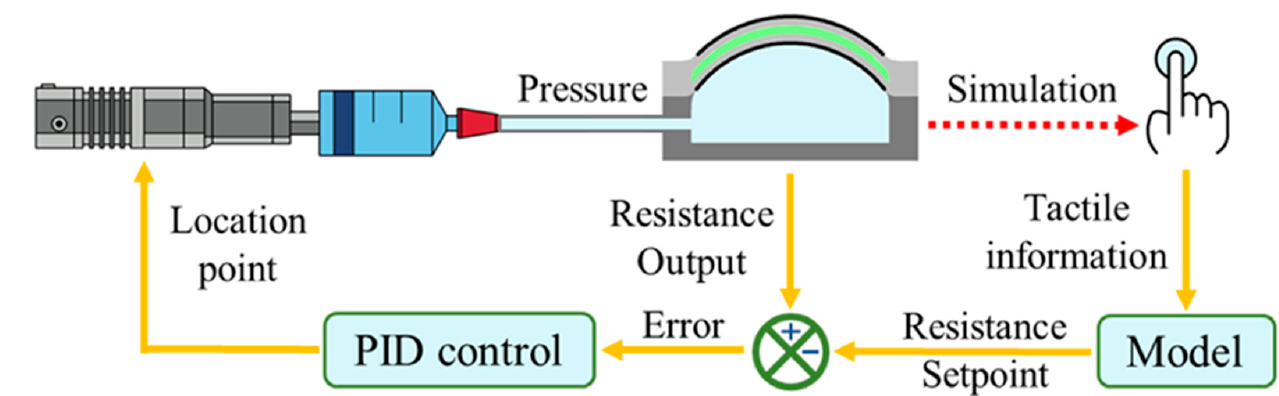
Figure 12. Closed-loop control flow chart of SEHPA.